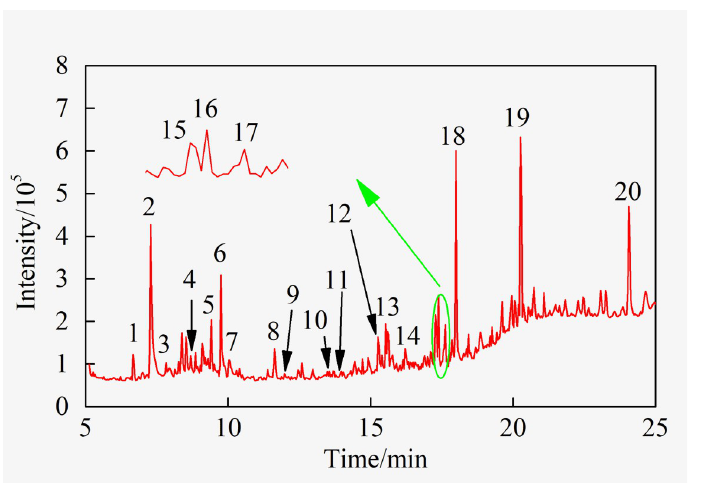
Fig 1. TIC of GC-MS of methanol